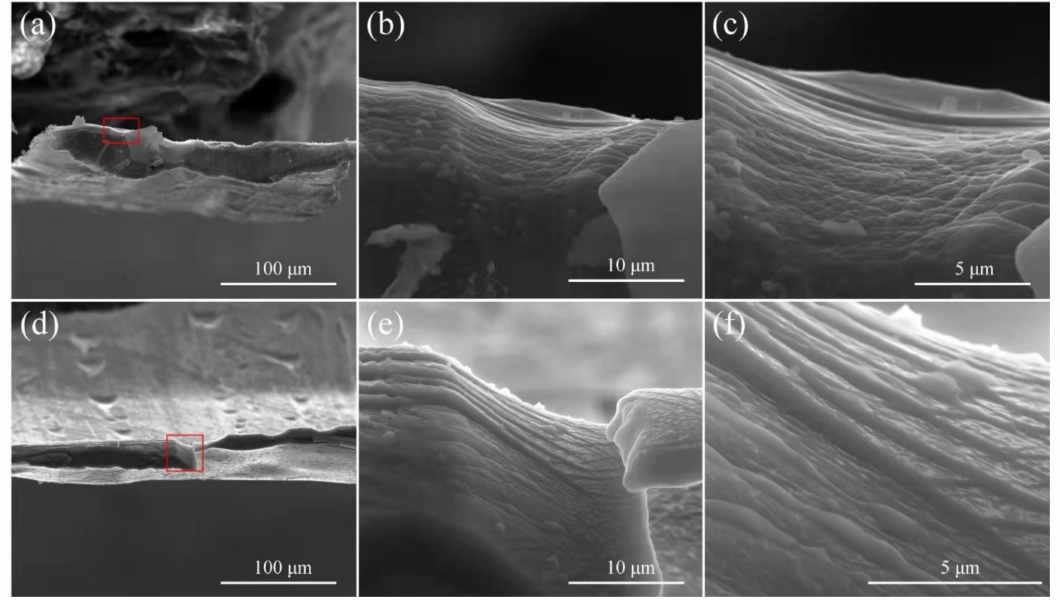
Figure 3. SEM images showing the characteristic shear bands near the fracture of the magnesium- based amorphous alloy ribbons: ( a – c ) Mg 68 Zn 30 Ce 2 , ( d – f ) Mg 66 Zn 30 Ce 4 .